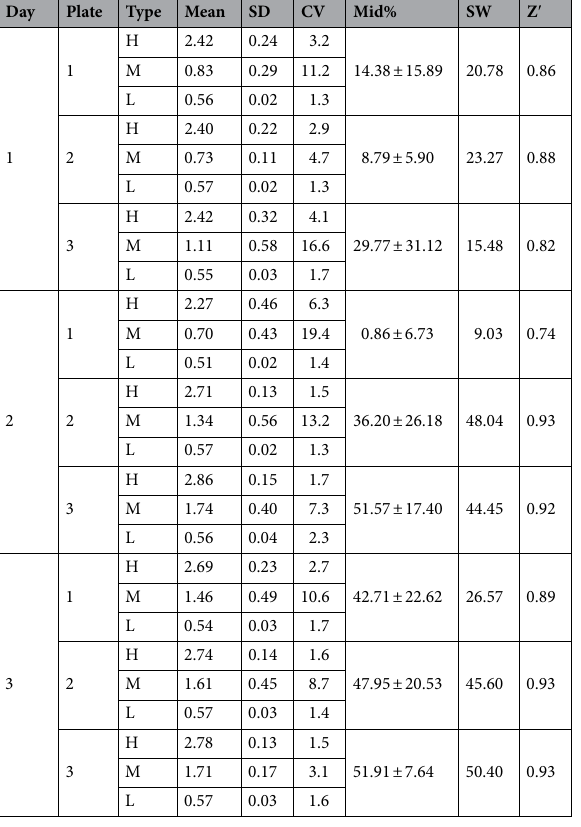
Table 1. Data of the (intra) plate uniformity study for expression temperature 22 °C. H: high signal; M: medium signal; L: low signal; SD: standard deviation; CV: coefficient of variation; Mid%: normalised mid signal; SW: signal window; Z’: Z’ factor. All Max (high) and Mid signal (unnormalized) CV’s < 20%. All min (Low) SD’s < Min (Max (High) SD, mid SD). All SW’s > 2 and Z’ > 0.4. Z’ and CV’s were calculated taken in consideration 10 repeats per equivalent signal. Normalized mid signal (mid %) SD’s below 20 and within- day fold shifts as well as average between-day fold shifts < 2 acceptance criteria were not fulfilled